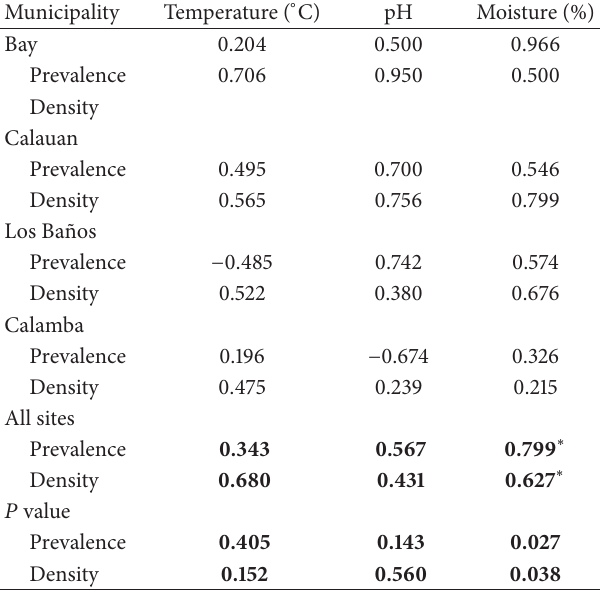
Table 2: Correlation coefficient ( 𝑟 ) of the prevalence and density of STH eggs with some physicochemical parameters of soils from selected towns in Laguna, Philippines.